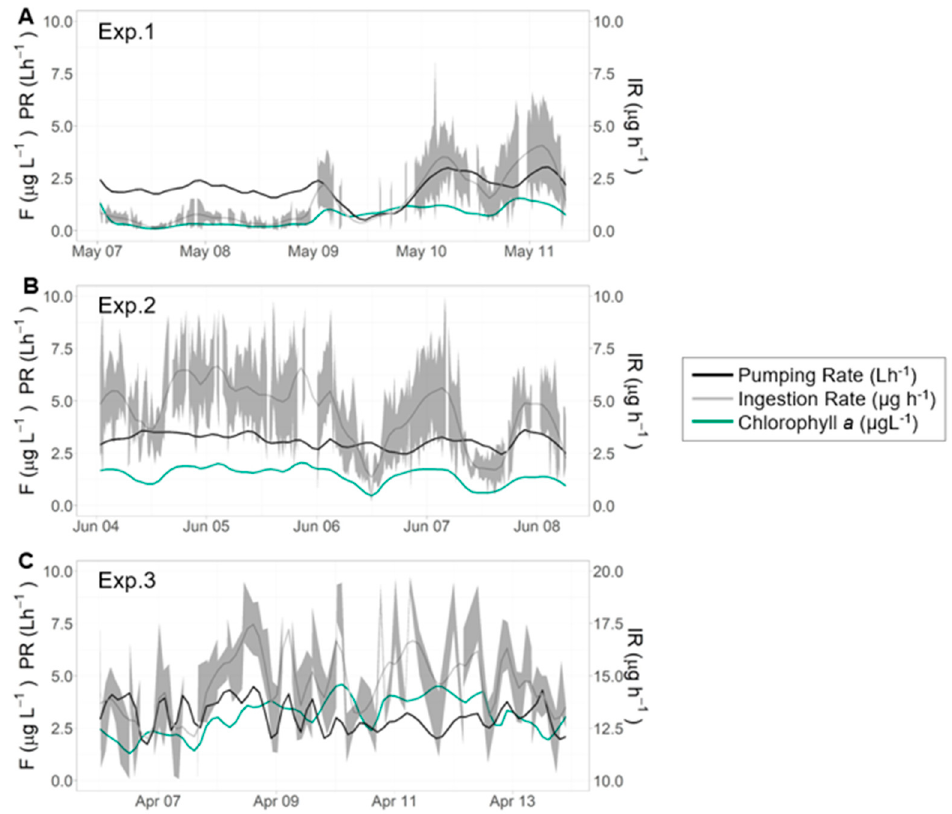
Figure 4. Pumping rate (PR) (Lh − 1 ) (black), chlorophyll a (F) ( µ gL − 1 ) (green), and ingestion rate (IR) ( µ gh − 1 ) (gray) averaged for all individual mussels in ( A ) Exp. 1, ( B ) Exp. 2. ( C ) Exp. 3. The gray shaded area is the standard deviation for IR.